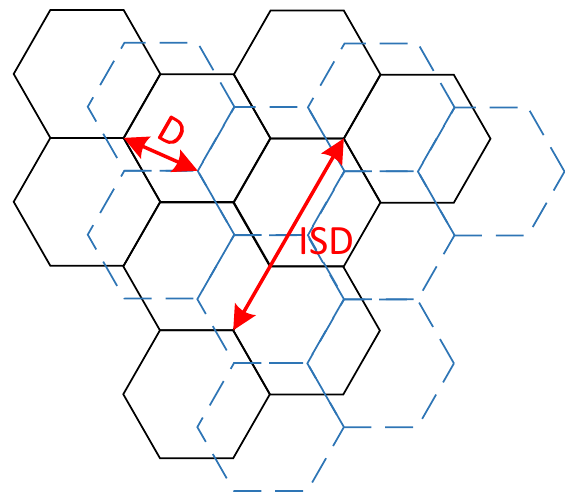
Figure 10. The offset between macro cellular networks. Table 7. ACLR model for LTE interfere and victim.